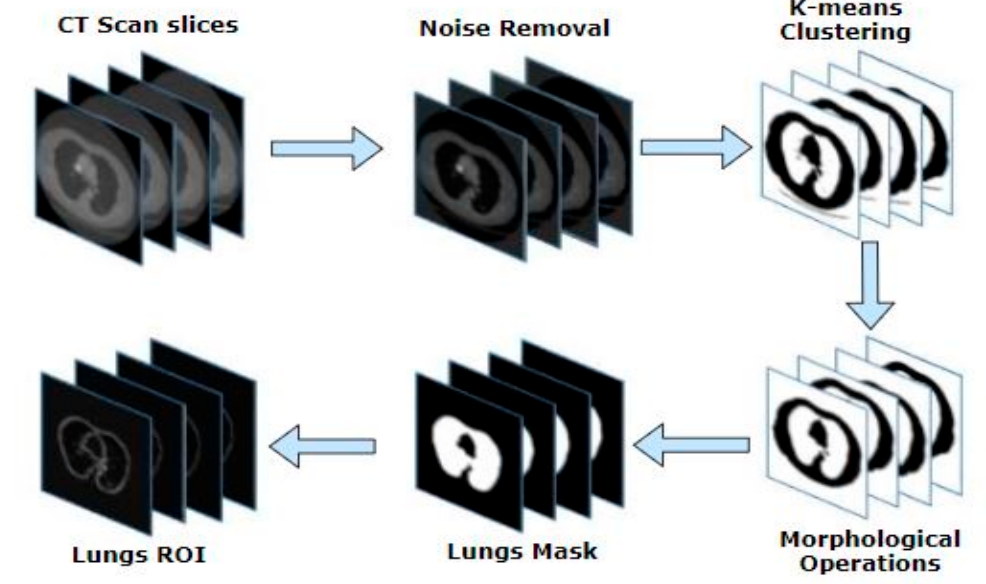
Figure 3. Preprocessing steps on (LIDC-IDRI) dataset.